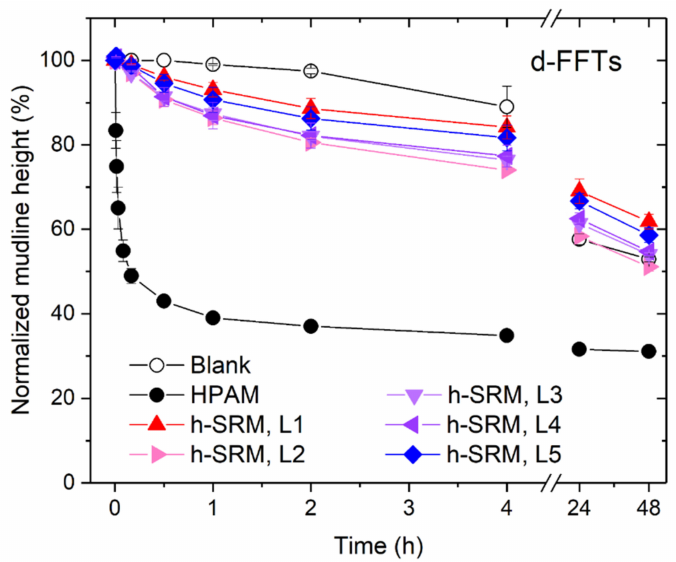
Figure 6. Mudline descending of d-FFTs, presented in the form of Normalized mudline height over Time. SRM-peptides are labelled as h-SRM, added at five dosage levels (L1–L5) being 4, 14, 22, 29, and 49 kg per ton of solids. Semi-bar represents the standard deviation of each experimental triplicate. The blank control and the industrial control (optimum dosage) were tested in parallel for comparison. Error bars represent the standard deviation of each experimental triplicate.